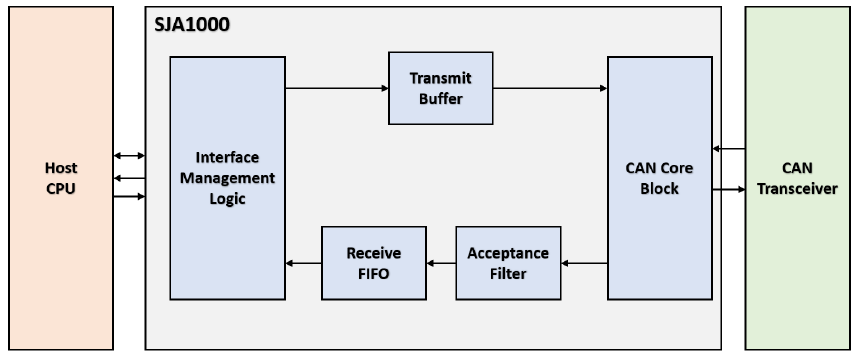
Figure 8. Block diagram of the adopted SJA1000 CAN controller